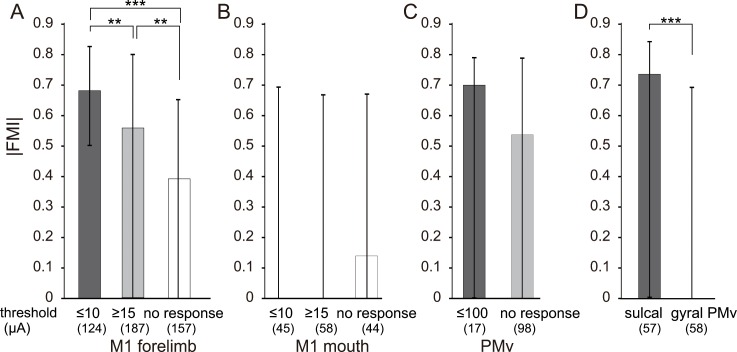
Variation of forelimb movement index (FMI) depending on both movement threshold for intracortical microstimulation (ICMS) and location on the cortical surface.(A) Median and interquartile range of |FMI| among recording sites at which ICMS evoked movements of the forelimb (i.e., digits, wrist, or elbow/shoulder) in the primary motor cortex (M1). The |FMI| values were compared across movement threshold ranges. ‘No response’ indicates recording sites of M1 at which ICMS up to 50 μA evoked no body movements, whereas ICMS within 2 mm of depth from the recording site in the same recording track evoked movements of the forelimb. The number of neurons in each category is shown in parentheses. Differences among the |FMI| values for different movement thresholds were evaluated using Kruskal–Wallis one-way ANOVA with Dunn’s test (**P < 0.01, ***P < 0.005). (B) Median and interquartile range of |FMI| in the mouth representation of M1. ‘No response’ is defined as in panel A. (C) Median and interquartile range of |FMI| in the ventral premotor cortex (PMv). Neurons in penetrations at which ICMS up to 100 μA evoked no body movements within PMv are denoted as ‘no response’. (D) Median and interquartile range of |FMI| are separately shown for the sulcal regions of PMv (within 2 mm of the arcuate sulcus) and the gyral regions of PMv. The index was higher in the sulcal regions than in the gyral regions of PMv (***P < 0.005, Mann–Whitney U-test). |FMI| is influenced by both baseline activity of neurons and modulation of activity during the task. In both M1 and PMv, the baseline activity was not significantly different among neurons with different movement thresholds (P > 0.3, Mann–Whitney U-test). In PMv, the baseline activities of the gyral regions were significantly higher than those in the sulcal regions (P < 0.01, Mann–Whitney U-test; the median values [interquartile range] in the sulcal and gyral PMv were 5.7 [2.9–10.4] and 8.6 [4.2–20.0]). Therefore, the difference in baseline activity between the sulcal and gyral regions in PMv accounts for roughly a 1.5-fold difference in |FMI| between the regions, and the difference in activity during task performance accounts for the rest of the difference in |FMI|.